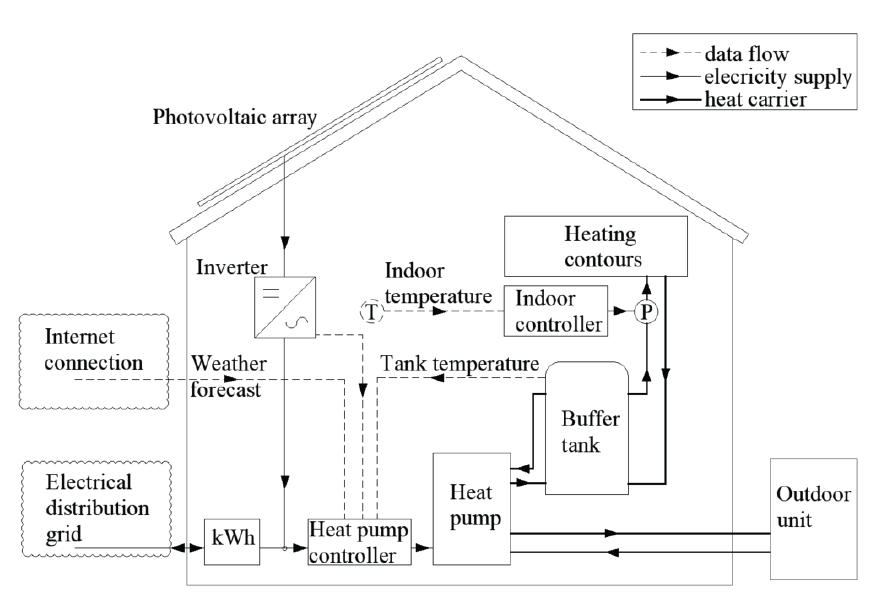
Fig 1. A heating system where the control algorithm can be